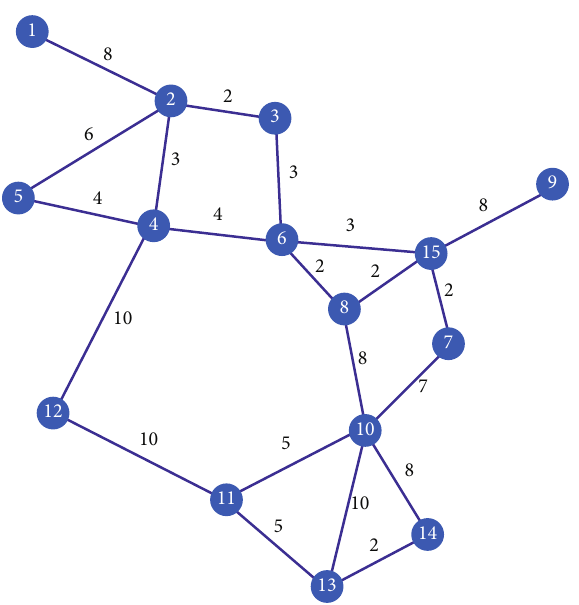
Figure 1: Mandl’s Swiss network